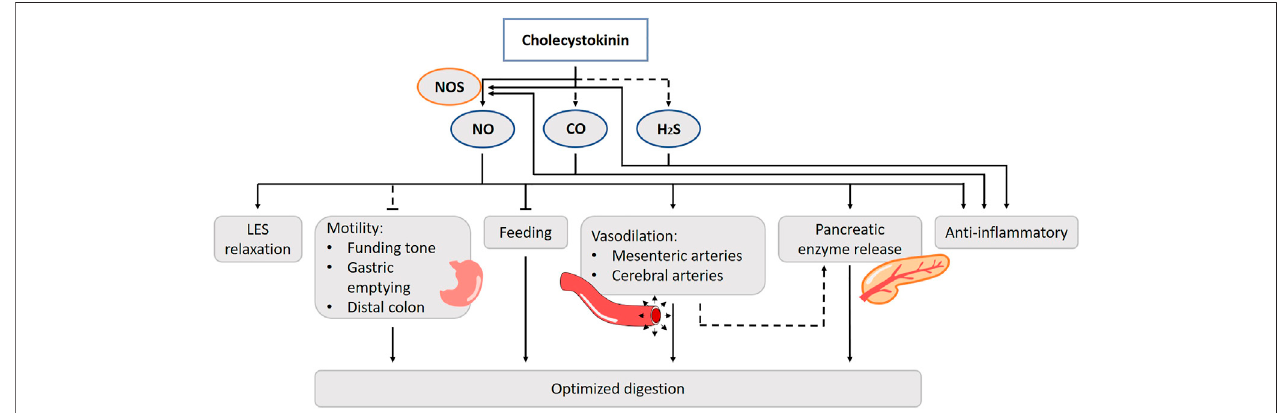
FIGURE 5 | Role of gasotransmitters on cholecystokinin ’ s (CCK) physiological functions. Solid lines are clear evidence – based on blockers and substrate administration. Dotted lines represent fi rst evidence for the presence of the pathway. CCK stimulates nNOS activity and thus NO release. NO is involved in the cholecystokinin effect on LES relaxation, intestinal vasodilation and food intake regulation. The CCK-NO-pathway of intestinal motility has only been hypothesized in literature.CCKanti-in fl ammatoryactionsareevokedbyreducingvascularandmacrophageiNOS-derivedNOproduction.TheinvolvementofCOandH 2 Sinthese functions have only been suggested, but lack experimental prove. NO, Nitric oxide; CO, Carbon monoxide; H 2 S, Hydrogen sul fi de; NOS, Nitric oxide synthase; LES, Lower esophageal